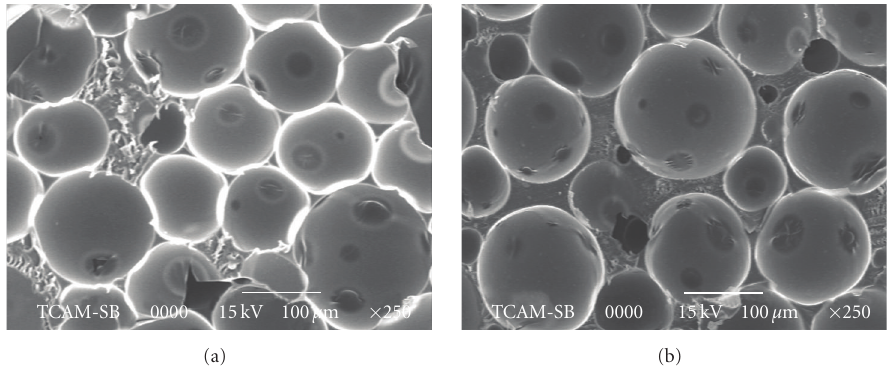
Figure 3: Microstructures of (a) neat (b) nanophased polyurethane foams.